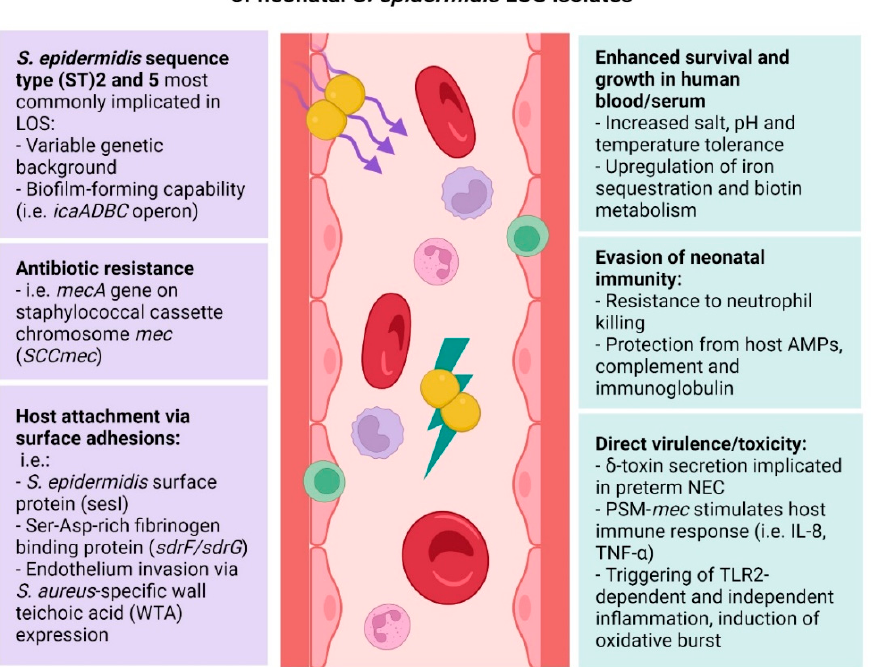
Figure 3. S. epidermidis functional and genetic determinants with potential role in late-onset sepsis (LOS pathogenicity). Created with BioRender.com.